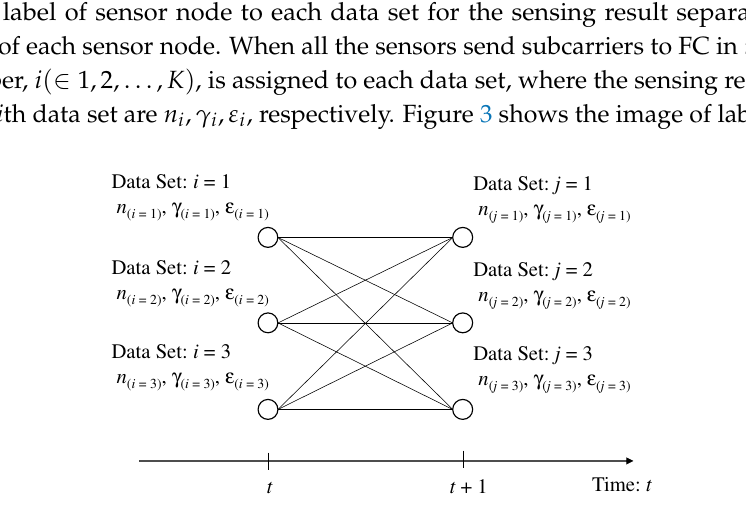
Figure 3. Example of labeling problem for data separation without the duplication of sensing